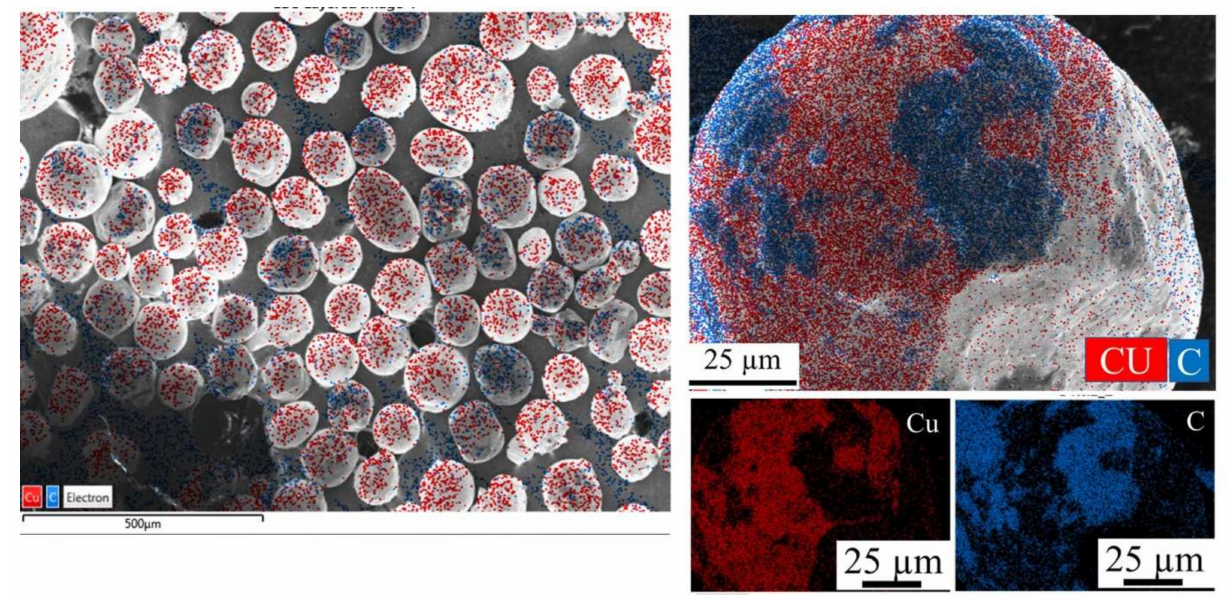
Figure 2. Energy dispersive spectroscopy (EDS) mapping of Cu particle after mixing with CNTs confirming attachment of CNTs on surface of